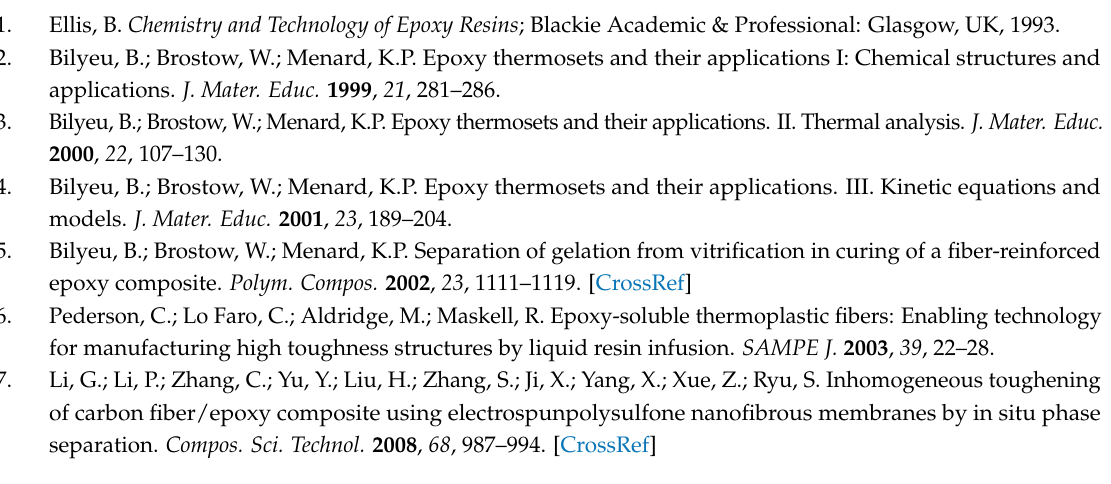
Figure S1: Storage modulus versus temperature for the neat samples with different veil contents after curing (a) and post-curing